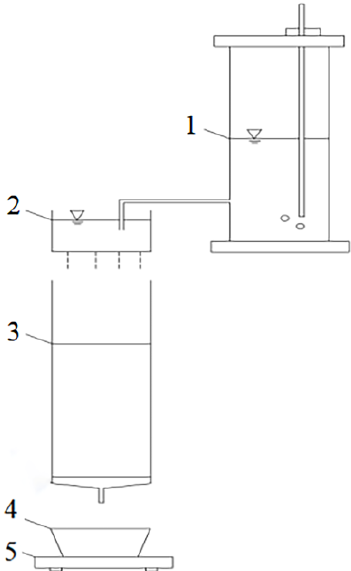
Figure 2. Apparatus for solute breakthrough experiments. 1 — Mariotte bottle, 2 — rainfall device, 3 — acrylic column, 4 — outflow collection container, 5 — automatic weighing scale.